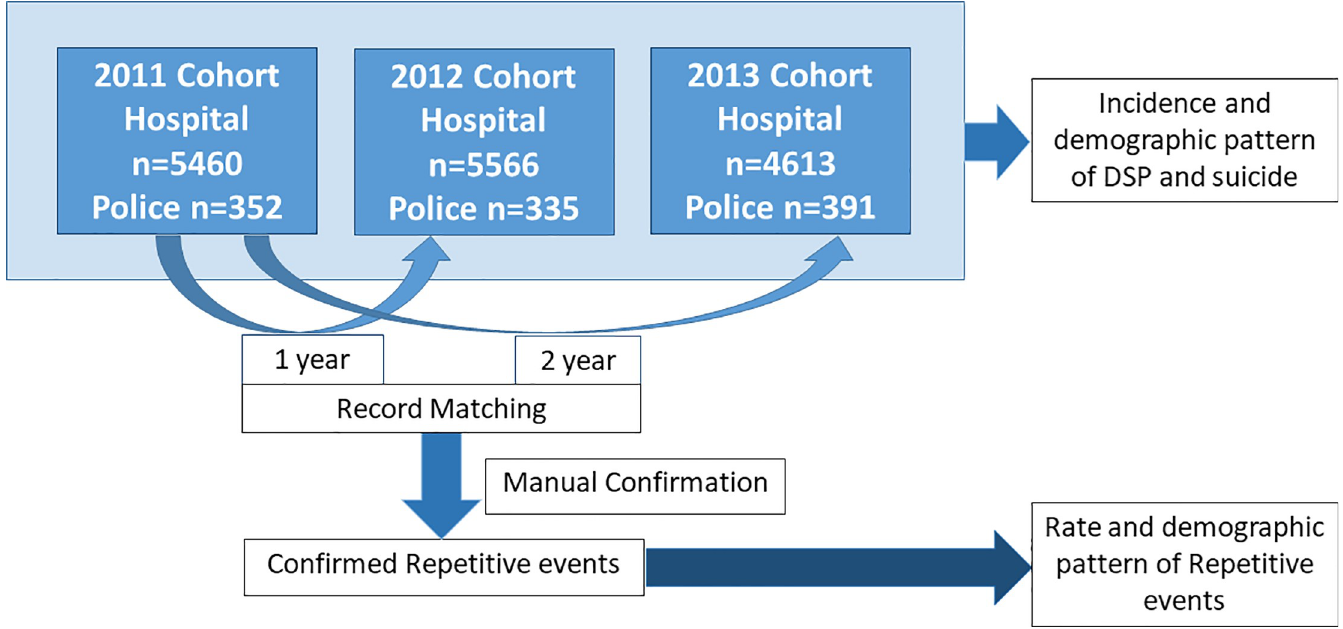
Fig 1. Recruitment and follow-up of the prospective repetition cohort. DSP admissions reported to all the hospital in KD and suicides reported to police stations were collected from 2011–2013. Data was collected regarding the incidence and demographic patterns of DSP and suicide. Details of the cohort of DSP patients presenting in 2011 (n = 4022) were matched with subsequent records of presentations in in 2012 and 2013 using a software with high sensitivity to identify repeat presentations. Manual confirmation was done in order to confirm repetitive events with a higher degree of specificity.